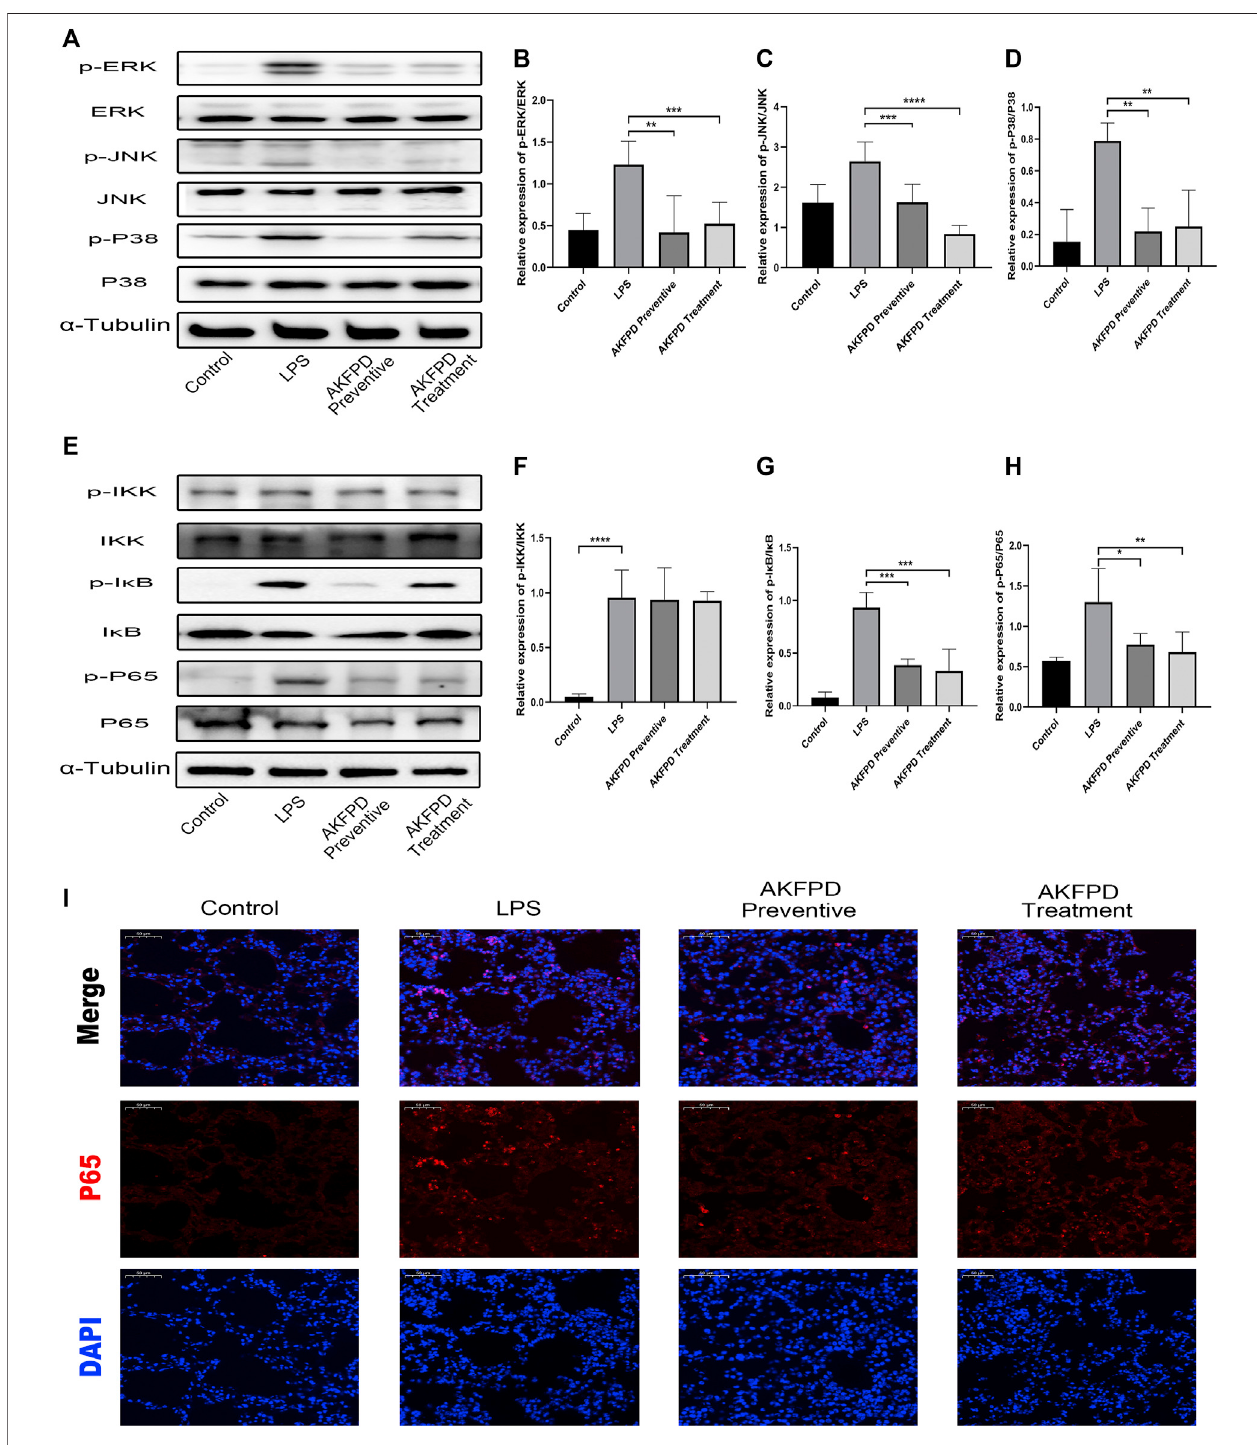
FIGURE 4 | Fluorofenidone suppressed NF- κ B/MAPK pathway activation in LPS-induced ALI mice. Western blot (A) and quantitative analysis of p-ERK, (B) p-JNK, (C) and p-P38 (D) inthelungtissueofdifferentgroupsofmice.Western blot (E) andquantitativeanalysisofp-IKK, (F) p-I κ B, (G) and p-P65 (H) inthelungtissue of mice. (I) Representative images of immuno fl uorescence staining of P65 in the lung tissue. Scale bar (cid:1) 50 μ m. Data were represented as mean ± SD. n (cid:1) 6 per group. * p < 0.05, ** p < 0.01, *** p < 0.005, and **** p < 0.001 vs. the LPS group.